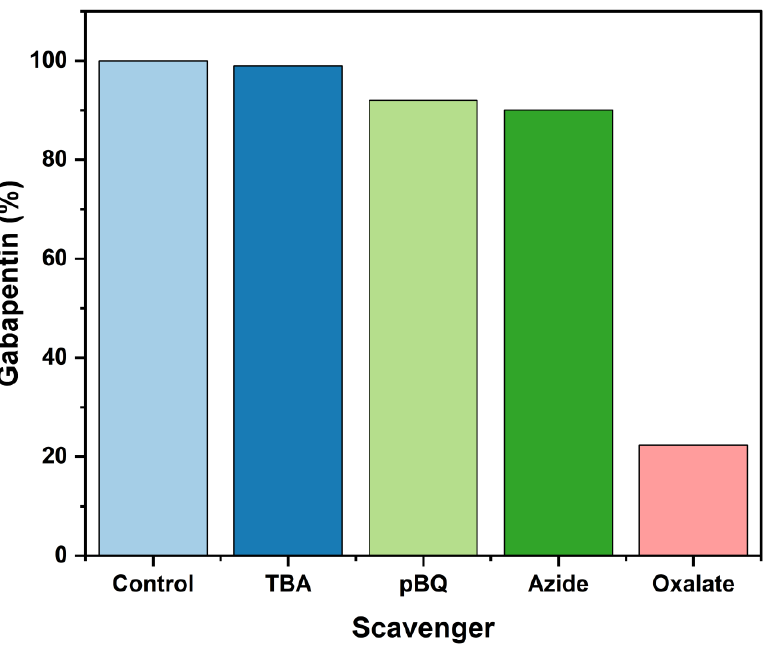
Figure 9. Effect of scavengers on GBP degradation in the Cu-TiO 2 /UVA process (GBP = 10 mg/L, pH = 8, catalyst = 0.4 g/L, scavenger (when added) = 1 M, reaction time = 20 min).